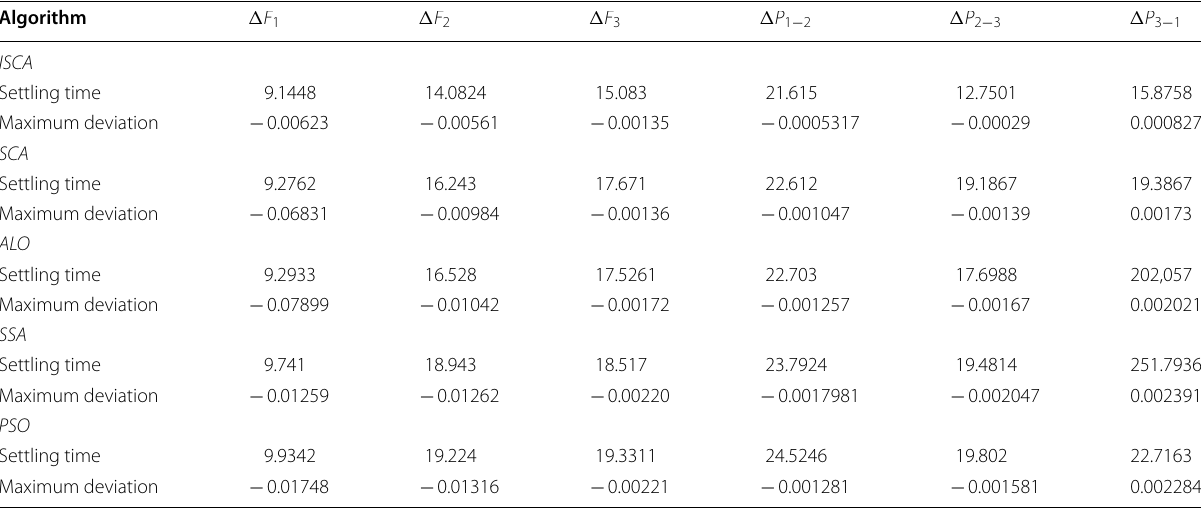
Table 4 Performance parameters of LFC with ISCA, SSA, ALO, SCA and PSO, in the case of SLD of 2% in area-1 and area-2 Algorithm